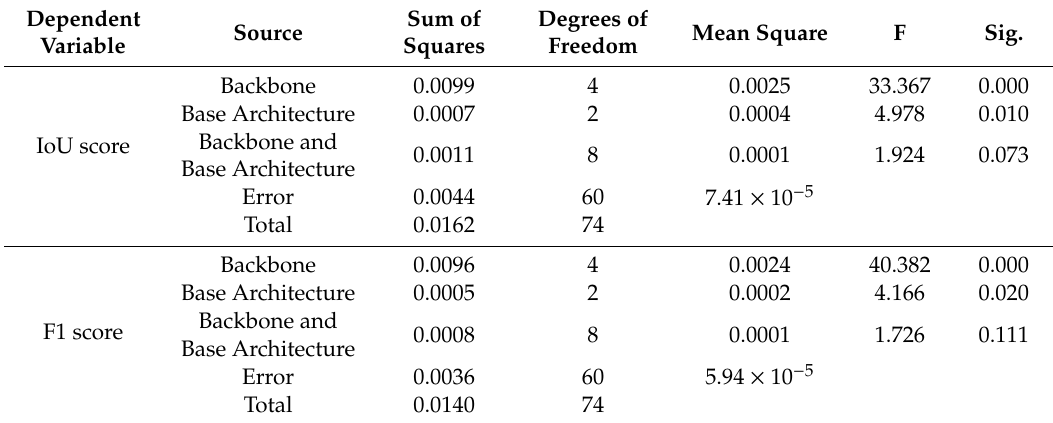
Table 3. ANOVA results for the effects of backbones and base architectures on performance.